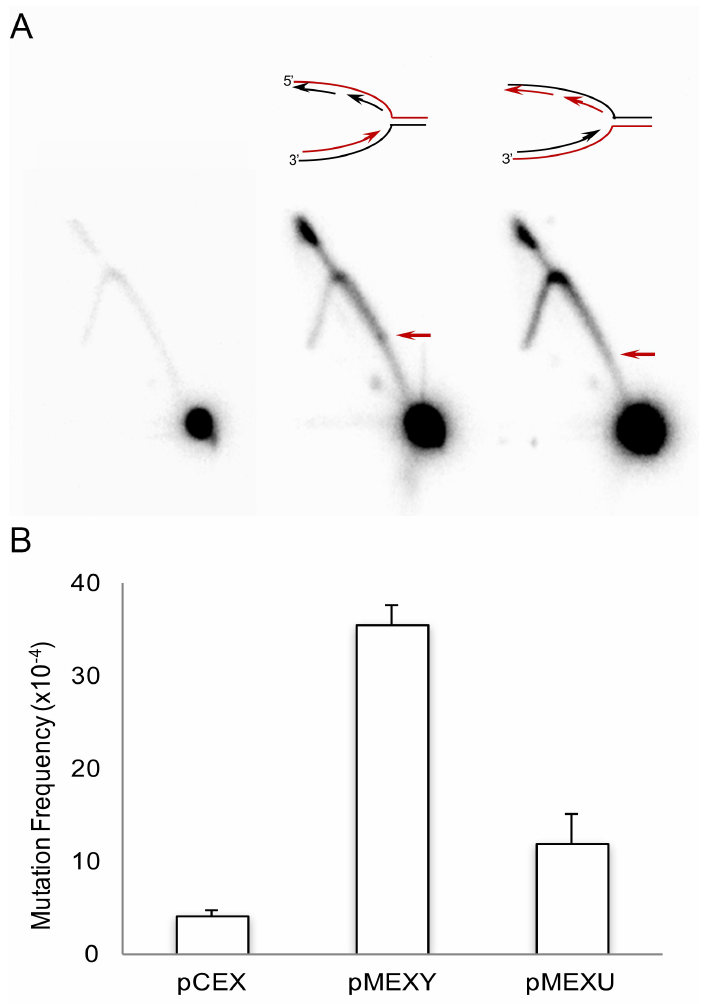
Figure 2. Effects of H-DNA orientation on DNA replication and genetic instability in mammalian cells. Reporter shutter vectors, pCEX and pMEXY and pMEXU, were transfected into mammalian COS-7 cells. The SV40 replication origin on the plasmids supports bi-directional replication in COS-7 cells. ( A ) Effects of orientation on H-DNA-induced replication stalling in mammalian COS-7 cells. Replication intermediates of plasmids were recovered 24 h post-transfection and were separated via 2-D gel electrophoresis. The fragments containing the H-DNA-forming or control sequences were probed by Southern blotting. The arrow designates the bulge on the Y-shaped replication arc, indicative of the accumulation of stalled replication intermediates. A representative image of three independent repeats is shown. ( B ) Effects of orientation on H-DNA-induced mutation frequencies in mammalian COS-7 cells. Mutation-reporter plasmids were recovered 48 h post-transfection, followed by DpnI digestion to remove the un-replicated plasmid DNA. Mutants generated were screened in indicator bacterial MBM7070 cells. Error bars show the standard errors of the mean value of three independent